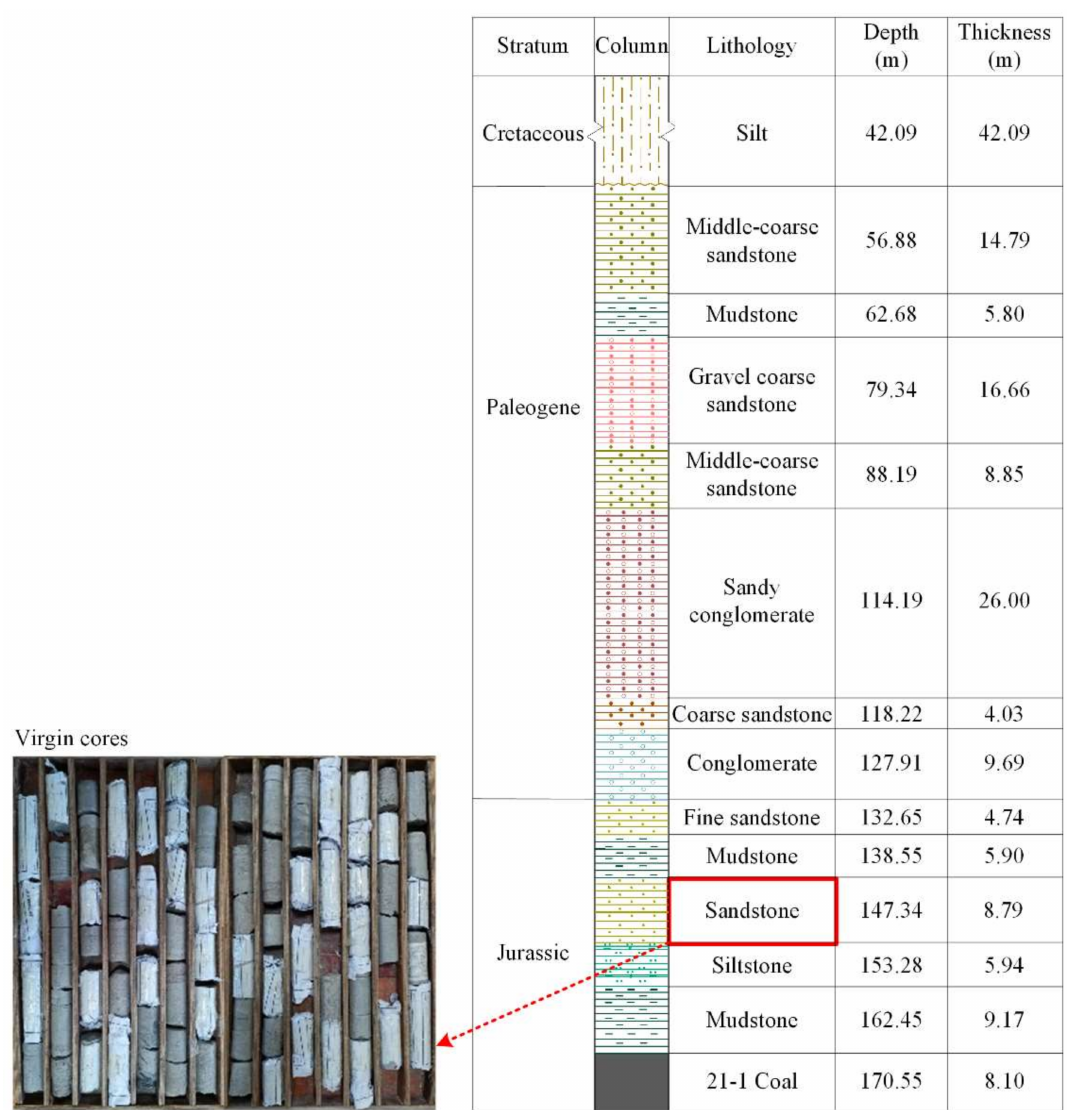
Figure 1. Borehole profile and WCS sampling